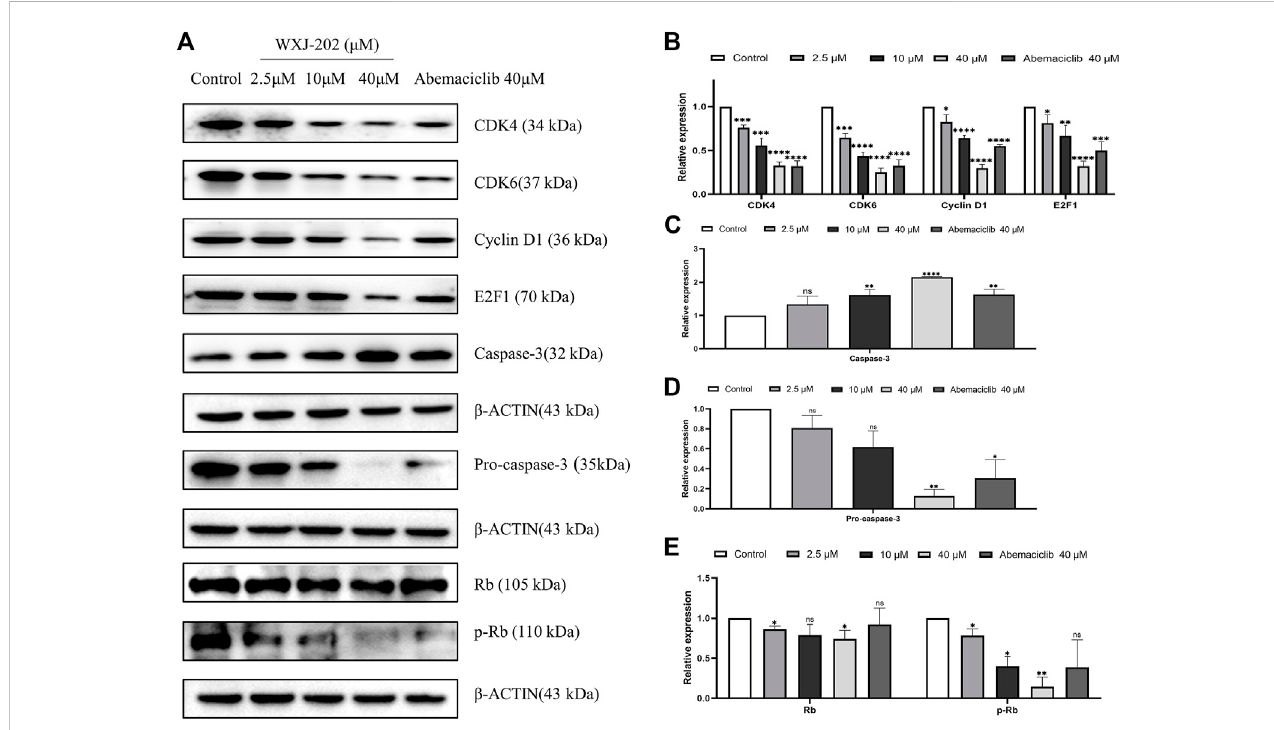
FIGURE 8 Effect of compound WXJ-202 on CDK4/6 - Rb - E2F pathway-related proteins in MDA-MB-231 cells. (A – E) The expression of cell apoptosis-related proteins and cell cycle-related proteins in MDA-MB-231 cells was analyzed by Western blotting. Results are representative of at least three independent experiments showing similar results. * p < 0.05 vs. control, ** p < 0.01 vs. control, *** p < 0.001 vs control, **** p < 0.0001 vs.